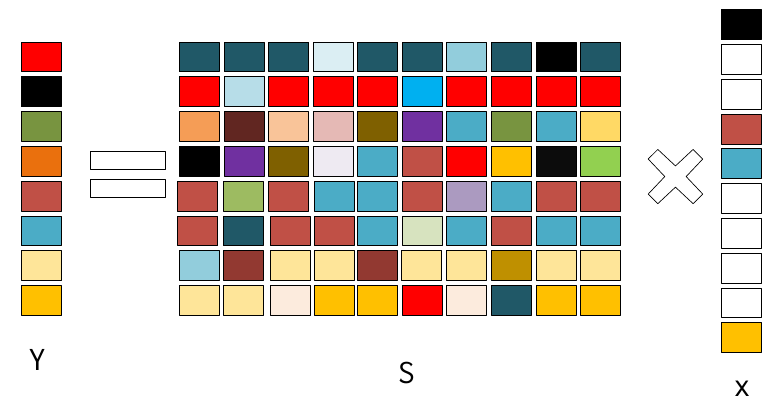
Figure 4. A schematic diagram of the SRC.